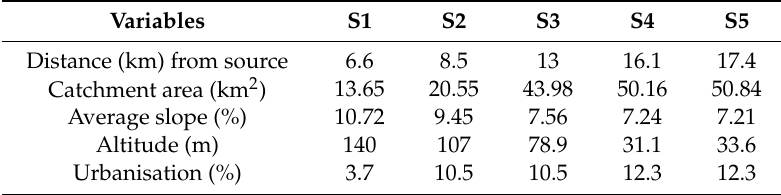
Figure 2. Map of each of the five sites along the River Medlock for which invertebrate sample counts and physicochemical readings were provided in a secondary dataset. The river flowed in a south-westerly direction towards Manchester City Centre. Sites 1 and 2 had a more rural catchment area, situated further from the city centre with increasing degrees of urbanisation when approaching the city centre. Sites 3, 4 and 5 were situated downstream of the Failsworth Wastewater Treatment Works (WwTW), which was a major point source of pollution. Created using ArcGIS 10.4.1. Table 1. Site characteristics of the river